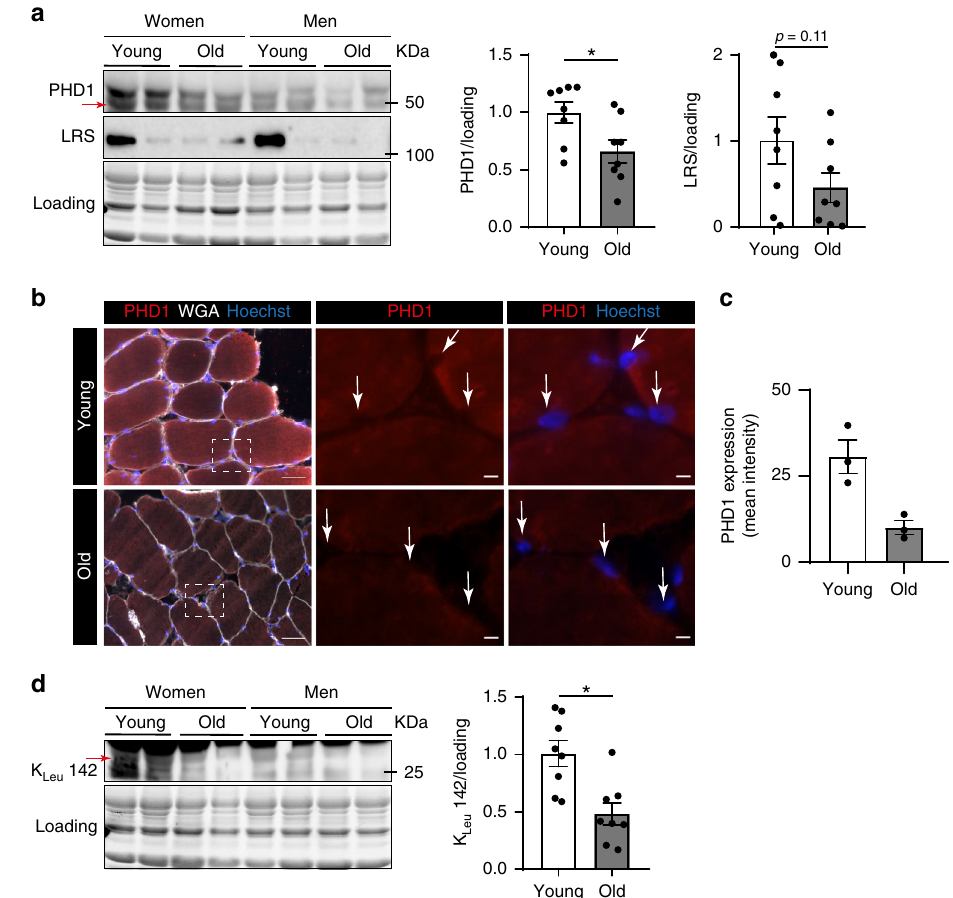
Fig. 6 PHD1 levels and LRS activity decline during aging. a Representative picture (left panel) and quanti fi cation (right panel) of western blot analysis of PHD1 and LRS protein levels in m. vastus lateralis biopsies from young (white bars) and old (gray bars) volunteers. Representative immuno fl uorescent pictures ( b ) and quanti fi cation ( c ) of PHD1 (red), Hoechst nuclear staining (blue) and wheat germ agglutinin (WGA, white) in young and old skeletal muscle. Arrows indicate nuclei. d Representative picture (left panel) and quanti fi cation (right panel) of western blot analysis of RagA leucylation (K Leu 142) levels in m. vastus lateralis biopsies from young (white bars) and old (gray bars) volunteers. Statistics: unpaired t test ( a ) (* p < 0.05; ** p < 0.01; *** p < 0.001; ns not signi fi cant). Dots represent values from different volunteers. Bar graphs represent mean ± SEM (error bars). Data is presented as fold change to young ( a , d ). Source data are provided as a Source Data fi